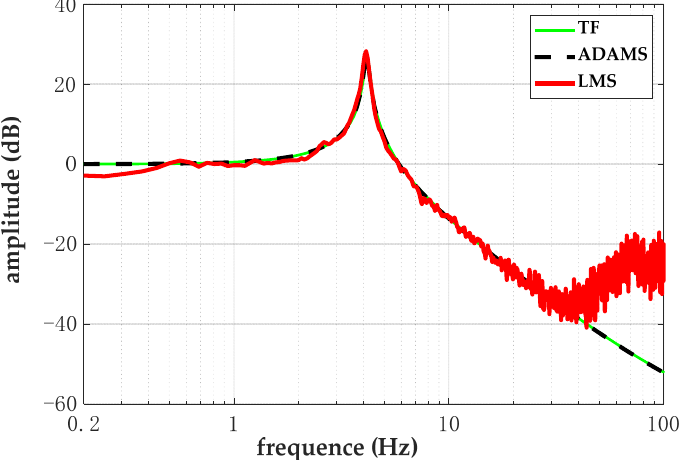
Figure 3. Validation of consistency between calculated transfer function (TF) and ADAMS model, and contrast with the LMS measured result .